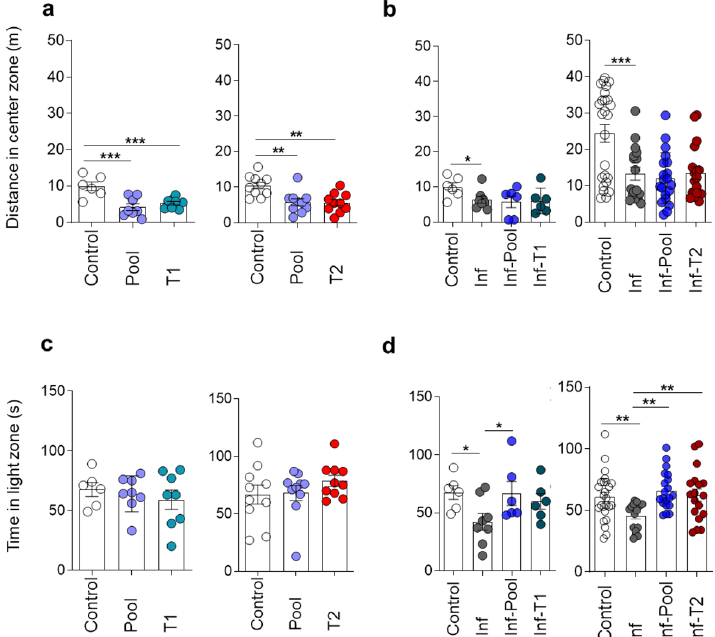
Figure 3. Immune stimulation attenuates the anxiety-like behaviour observed in Pb A-infected mice. Healthy or Pb A-infected (and treated) mice were immune stimulated, or not, with the Pool, T1 or T2 strategies. Behavioural tasks were performed from day 88 to 92 post-infection (77 to 81 days after CQ treatment). Distance travelled in the centre of the arena during the training session of the open field task (OFT) by healthy ( a ) and infected ( b ) immune stimulated mice. Time in the light zone of the Light/Dark apparatus by healthy ( c ) and infected ( d ) immune stimulated mice. For definition of experimental groups see Legend of Fig. 2. Data are expressed as mean and s.e.m. ***P < 0.001; **P < 0.01; *P < 0.05; One-way ANOVA was used [A, F (2,19) = 11.01 and F (2,27) = 8.901; B, F (3,22) = 3.147 and F (3,76) = 9.175; D, F (3,22) = 3.184 and F (3,76) = 4.727]. Data shown represent one of two to five independent experiments (Control, Pool, T1, T2, Inf, Inf-Pool, Inf-T1); and a pool of two independent experiments (Control, Inf, Inf-Pool,